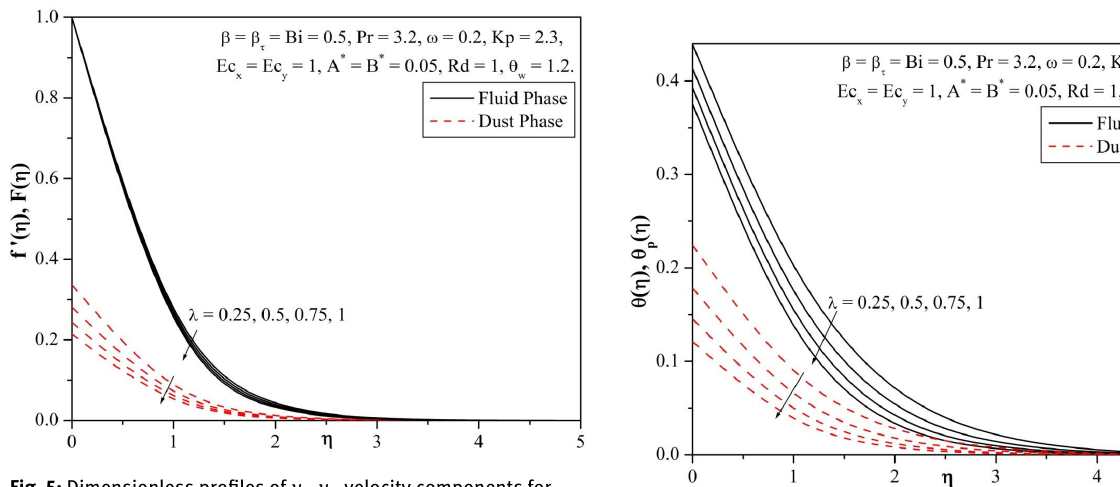
Fig. 5: Dimensionless profiles of u , u p velocity components for different values of λ .